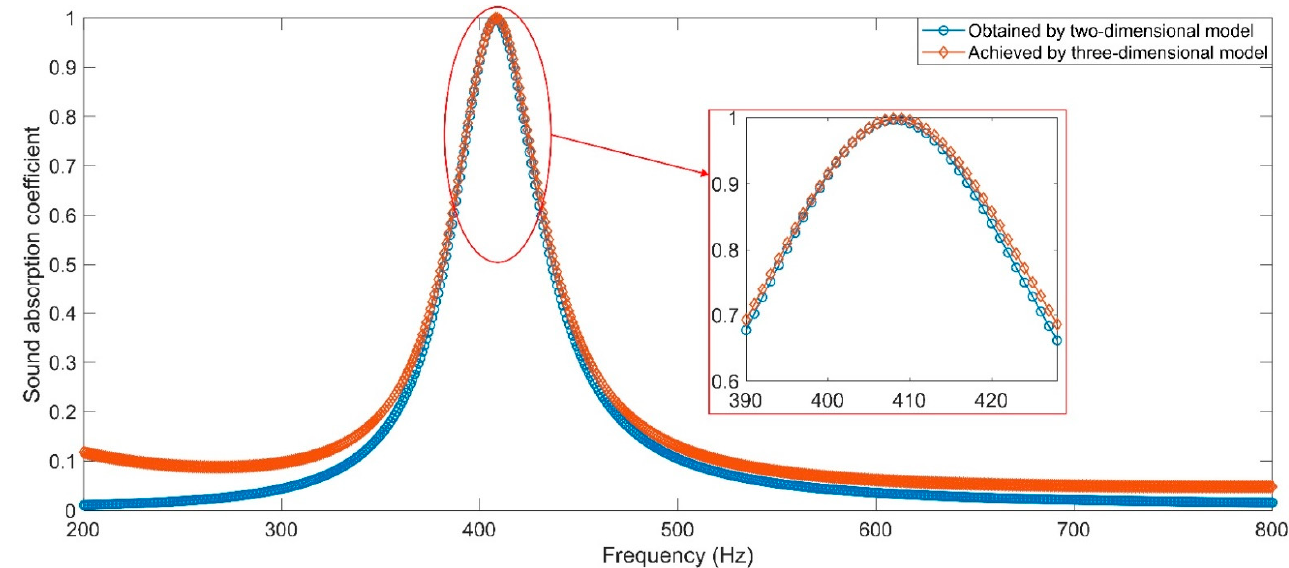
Figure 13. The comparison of sound absorption performances obtained by two-dimensional model and those achieved by three-dimensional model.